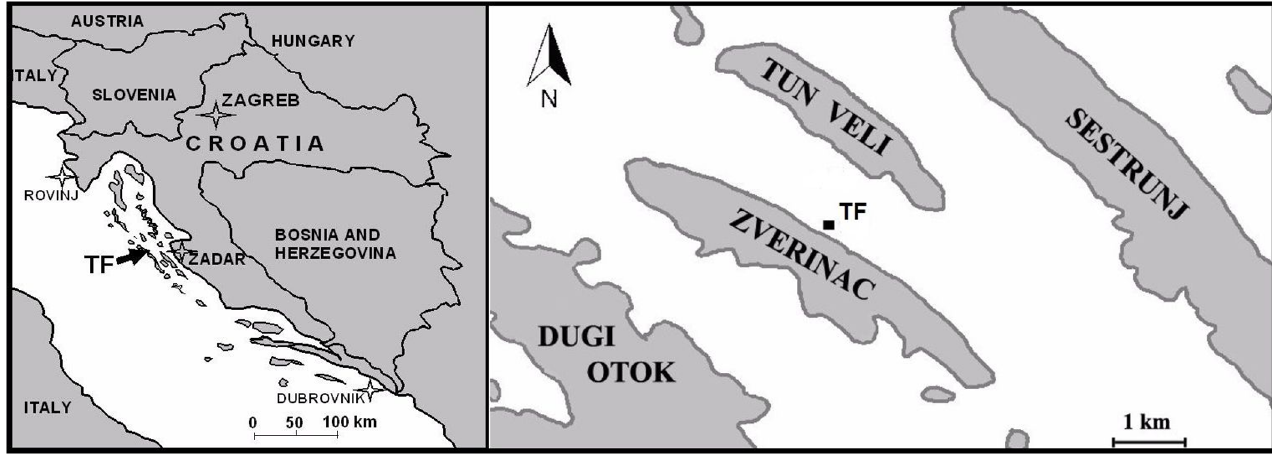
Fig. 1. Sampling locations on a commercial tuna farm (TF) in the Middle Adriatic. (a) Sampling locations within Croatia. (b) Close-up view of sampling locations on the tuna